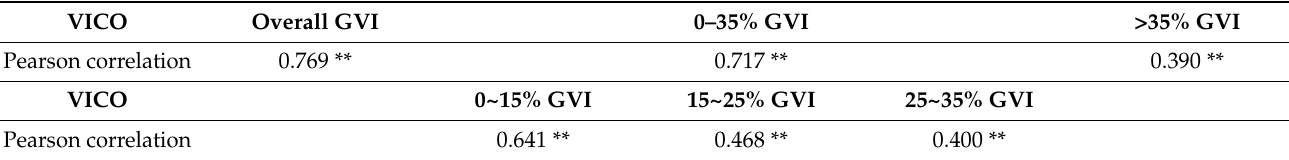
Table 3. Correlation analysis of the VICO and